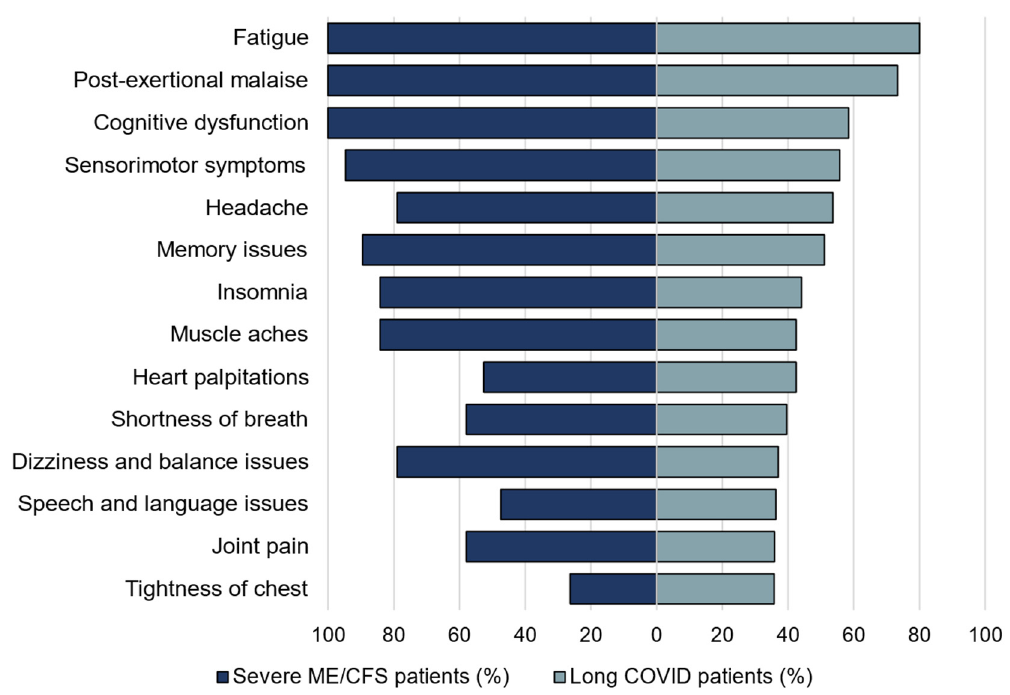
Figure 5. Comparison of the symptoms reported in the long COVID patients after 6 months with those in the severely ill ME/CFS patients. The symptoms are ranked based on the frequencies reported in the long COVID patients. The frequencies of these symptoms in the severely ill ME/CFS are similar to those reported in the long COVID. Supplementary Materials: The following are available online at https://www.mdpi.com/article/10 .3390/healthcare9101290/s1, Figure S1: Comparison of the Quality of Life of Severely Ill ME/CFS SIPS Patients. Table S1: List of Clinical Laboratory Tests. Table S2: List of Antibody and Antigen Tests of Viral and Bacterial